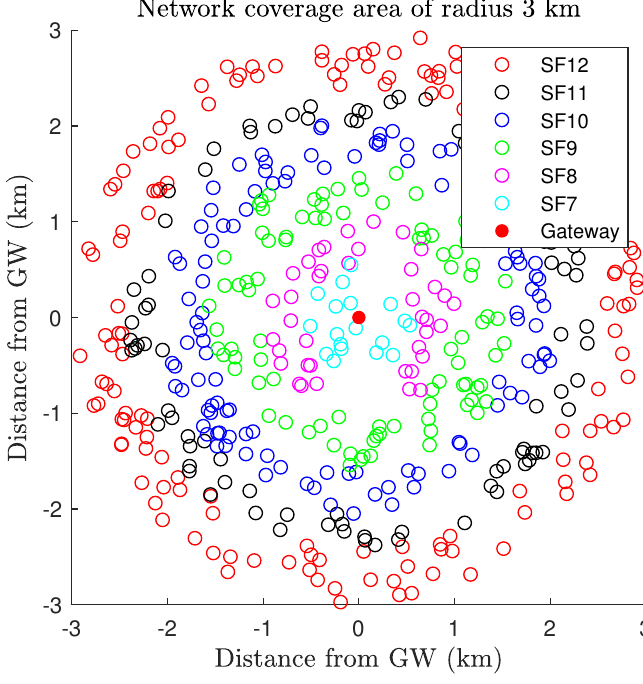
Figure 4. SF allocation of 500 nodes with Fibonacci